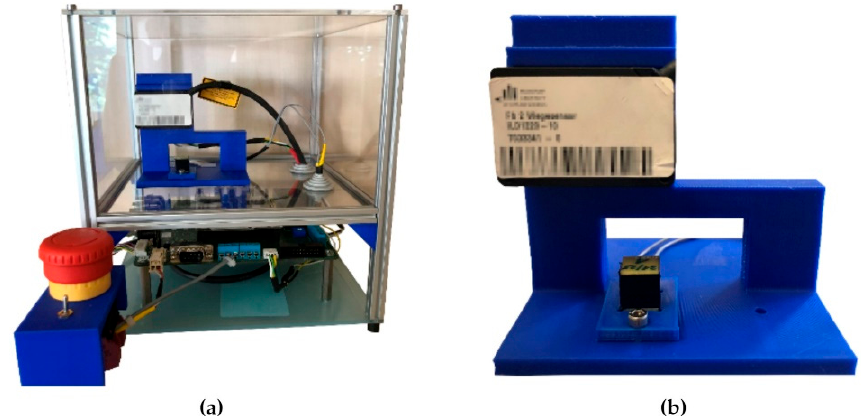
Figure 6. Test bench ( a ) fully assembled ( b ) detailed view of stacked DEA, laser sensor, and mounting. After 1 s a rectangular voltage signal is applied to the actuator. It has a duration of 2 s and jumps from 0 V to 1000 V and back again. Figure 7a shows the reaction of the actuator. To read out the sensor the RS-422 interface and the current signal were used. A break of 10 min was taken between each of the three measurements to allow the actuator to relax. The absolute distance is plotted on the Y -axis. Before the measurement, the two measuring resistors were checked with a multimeter. The factor for the conversion to the respective current